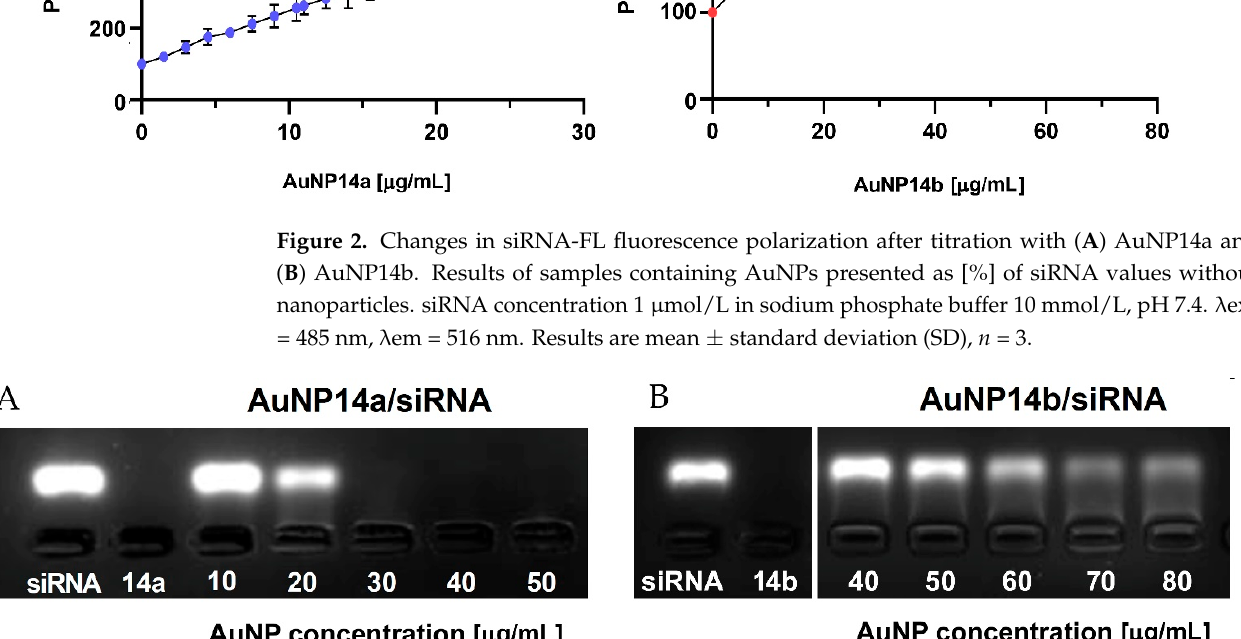
Figure 3. 3% Agarose gel electropherograms of ApoE4 siRNA complexed with gold nanoparticles, ( A ) AuNP14a and ( B ) AuNP14b. Samples containing 1 µmol/L siRNA per line and nanoparticles applied in the corresponding concentrations were prepared in sodium phosphate bu ff er 10 mmol/L in the presence of GelRed stain. Gels were visualized upon transillumination at 525 nm.